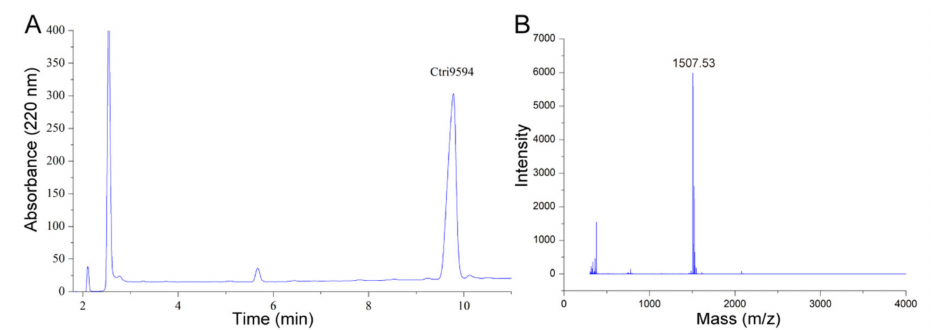
Figure 4. RP-HPLC and mass spectrometry analyses of the chemically synthesized Ctri9594 mature